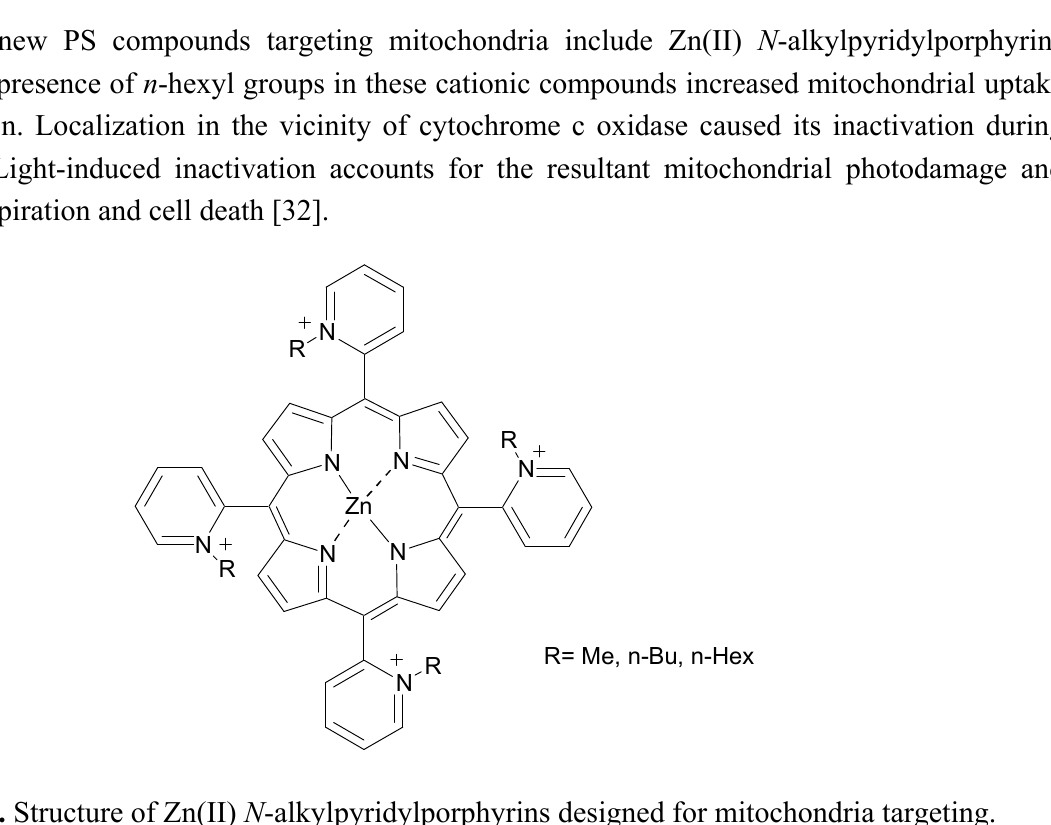
Figure 4. Structure of Zn(II) N -alkylpyridylporphyrins designed for mitochondria